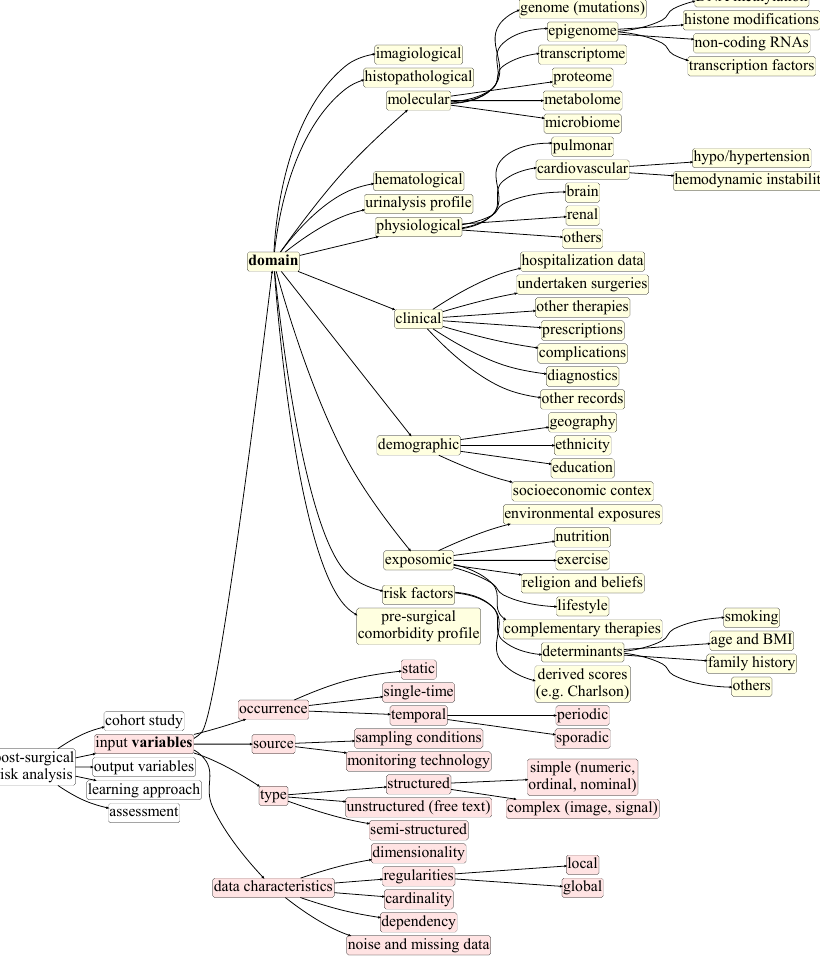
Figure 3. Taxonomy for postsurgical risk analysis: available data ( input